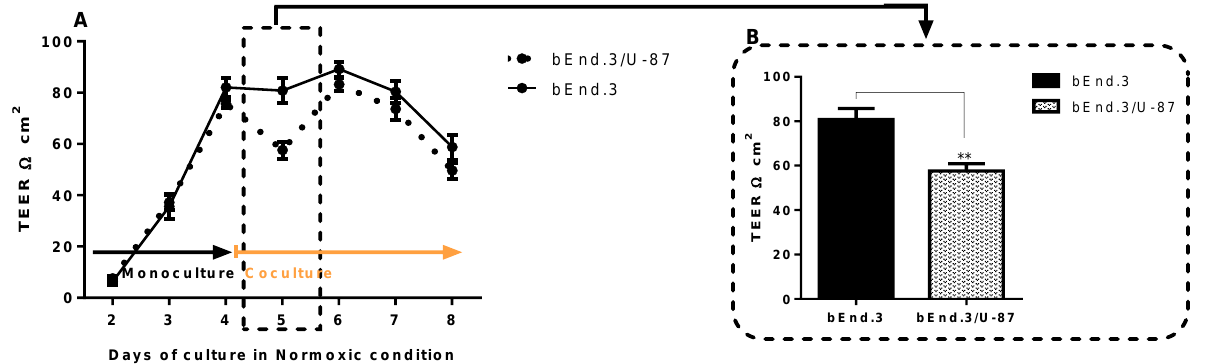
Figure 5. Transendothelial electrical resistance (TEER) of bEnd.3 monolayers. ( A ) Confluent mono- cultures of bEnd.3 cells were cocultured with glioblastoma U-87 cells under normoxic conditions (21% O 2 ). TEER was only statistically different to control monolayers on day 5, and on all other days were statistically not different ( p > 0.05). ( B ) Peak-TEER of bEnd.3 monolayers after 24 h coculture with glioblastoma U-87 cells (** p = 0.002), ( n = 3).